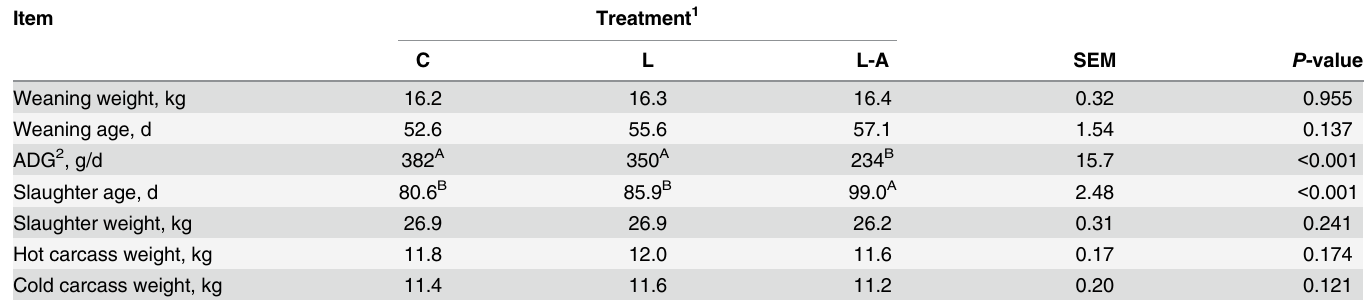
Table 2. Effects of addition of linseed or linseed and marine algae to the diet on growth and carcass parameters of Navarra breed lambs.